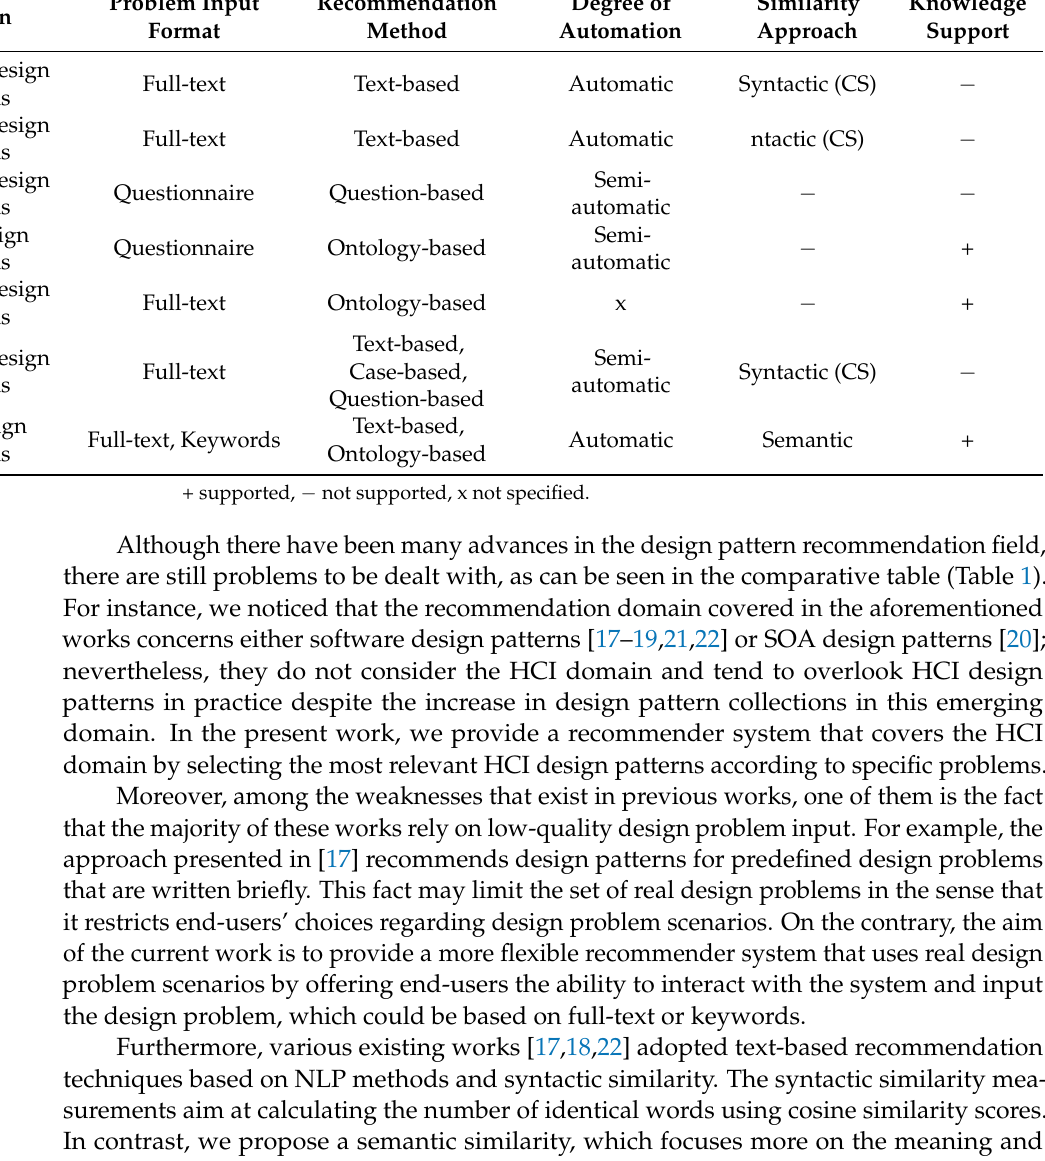
Table 1. Comparison of the proposed work with existing design pattern recommendation systems.